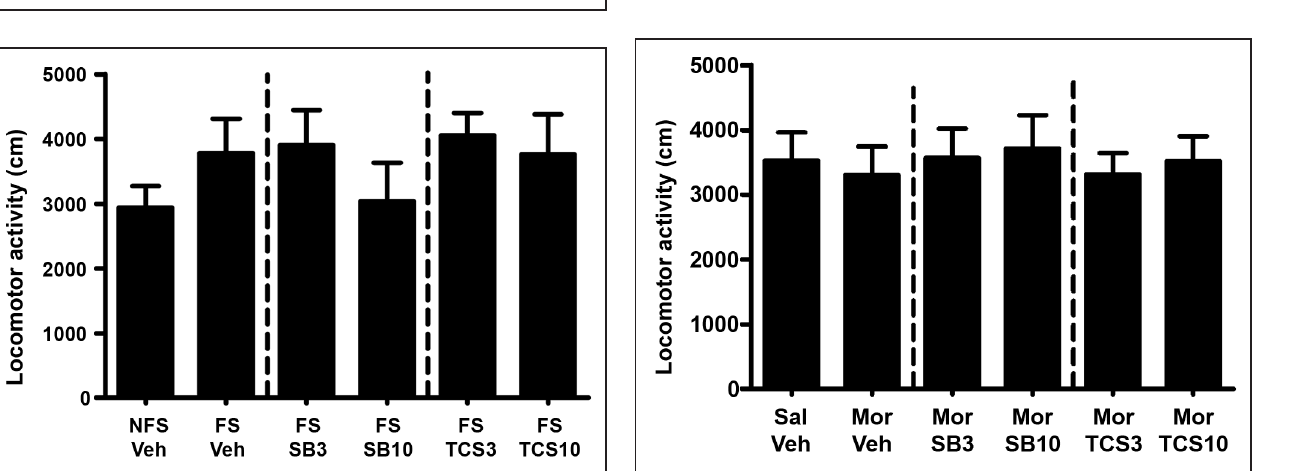
FIGURE 3 | Effects of microinjections of vehicle (Veh), SB334867 (SB) at 3.0 or 10.0 µ g (SB3 and SB10), or TCSOX229 (TCS) at 3.0 or 10.0 µ g (TCS3 and TCS10) in the NAcSh on footshock-induced reinstatement of morphine CPP. * p < 0.05, the footshock group (FS + Veh) compared to the control group non-footshock (NFS + Veh). # p < 0.05, ## p < 0.01, compared to the FS + Veh. All data are expressed as mean ± SEM.